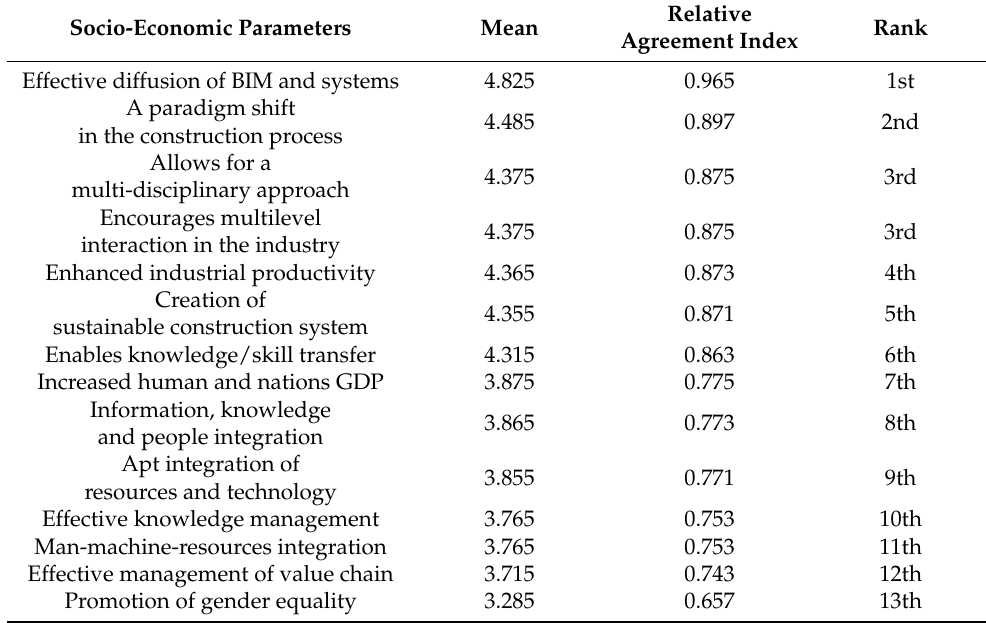
Table 9. Socioeconomic Implications of Construction 4.0 Innovations in Industrial